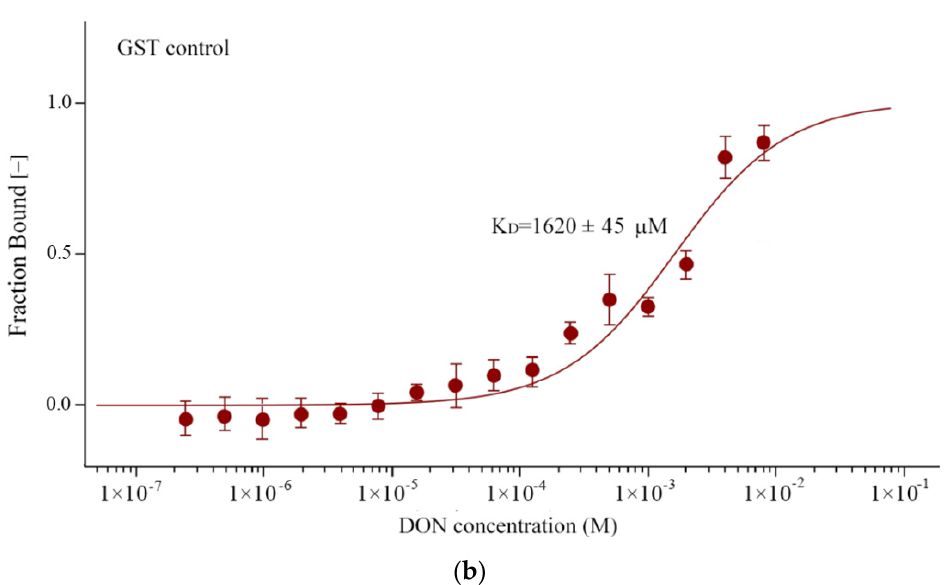
Figure 4. Affinity analysis between TaARL6IP4 and DON in vitro . ( a ) GST-tagged TaARL6IP4 recombinant proteins (100 nM) were separately incubated with 16 twofold serial dilutions of DON, starting with 8 mM. ( b ) GST recombinant proteins (control) (100 nM) were separately incubated with 16 twofold serial dilutions of DON, starting with 8 mM. All values are the means ± standard deviations of three replicates.